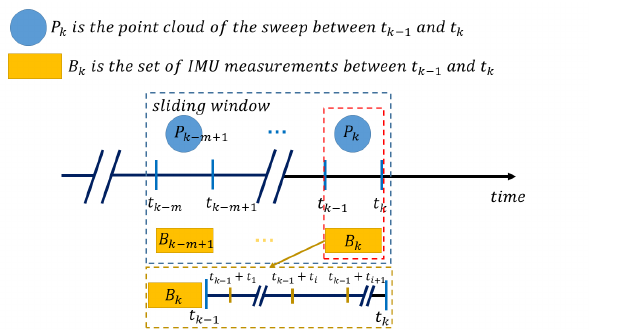
Figure 2. Time alignment between LiDAR point cloud P k and the set of the IMU measurements B k